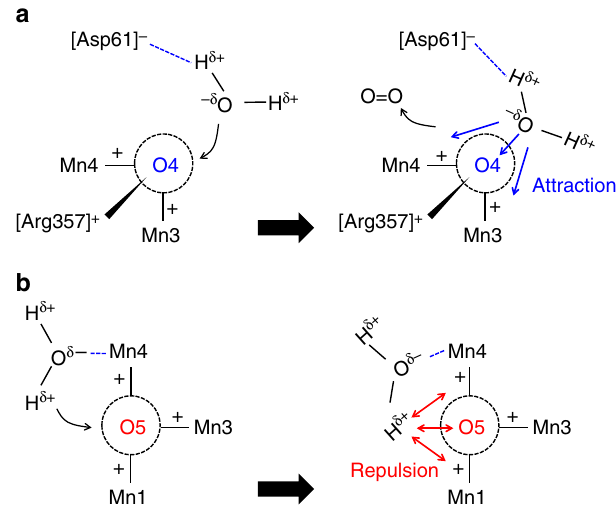
Fig. 5 Difference in the orientations and interactions of the incorporating H 2 O molecule. a The O4 site. Anionic D1-Asp61 attracts the H δ + and orients the O δ – of the incorporating H 2 O toward cationic Mn3(III), Mn4(III), and CP43-Arg357, resulting in attraction. b The O5 site. The absence of an anionic H-bond acceptor and the nature of the incorporating H 2 O as a ligand of Mn4 force the H δ + of the incorporating H 2 O to face cationic Mn1 (III), Mn3(III), and Mn4(III), resulting in repulsion. The absence of D1- Asp61 near O5 would be energetically disadvantageous for incorporating H 2 O into the O5 site. O4 is located at the “ corner ” of the Mn3 – O4 and O4 – Mn4 bonds. Due to the presence of D1-Asp61, O W539 δ – can always be oriented toward the vacant O4 site, which makes incorporation energetically favorable (Supplementary Figure 4a). On the other hand, if W2 is incorporated into the center of the Mn1 – (O5) – Mn4 bond, H W2 δ + is oriented toward cationic Mn1(III) and Mn4(III), causing repulsion (Supplementary Figure 4b). Indeed, QM/MM calculations show that neither W2 nor W3 was incorporated into the vacant O5 site of the O5- depleted Mn 4 CaO 4 cluster. Depletion of O5 did not even affect the H-bond D1-His190 (~2.5